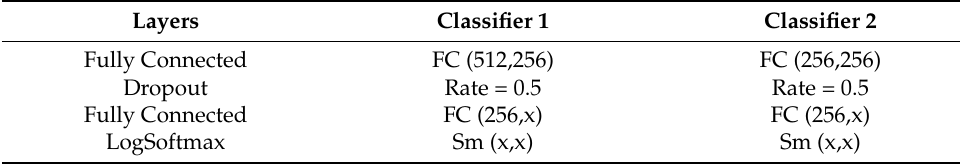
Table 3. Classifiers are used in this paper.